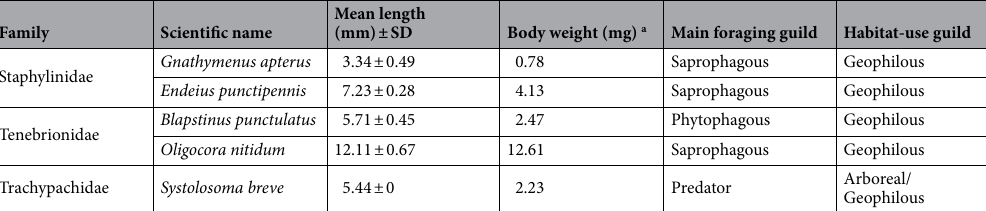
Table 3. Traits utilized to examine beetle (Coleoptera) functional diversity in homegardens from Andean temperate ecosystems, southern Chile. a Species body weight was calculated from measured body lengths following Johnson and Strong 94